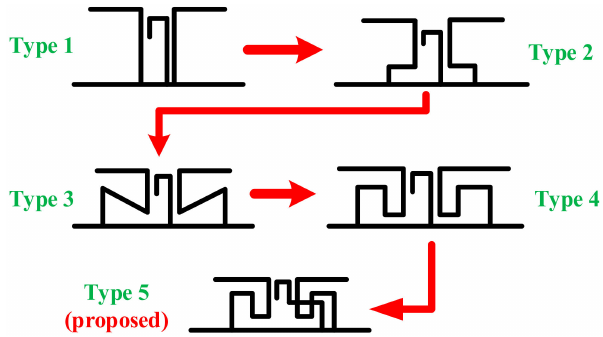
Figure 2. The evolution of the proposed low-profile ME dipole.